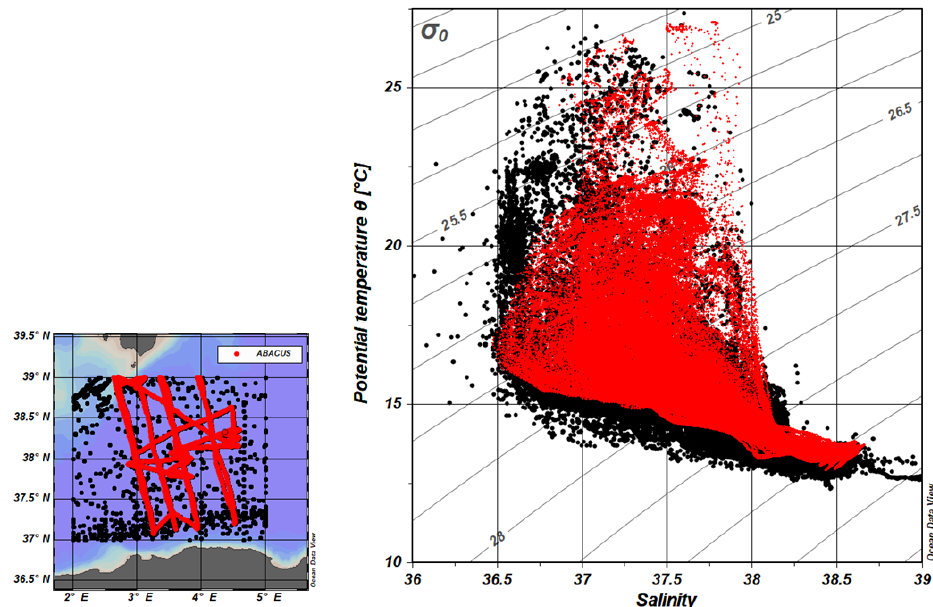
Figure 6. (cid:50) – S diagram comparing historical oceanographic observations from 1909 to 2011 (black dots) to ABACUS data (red dots). The associated map shows the spatial distribution of the